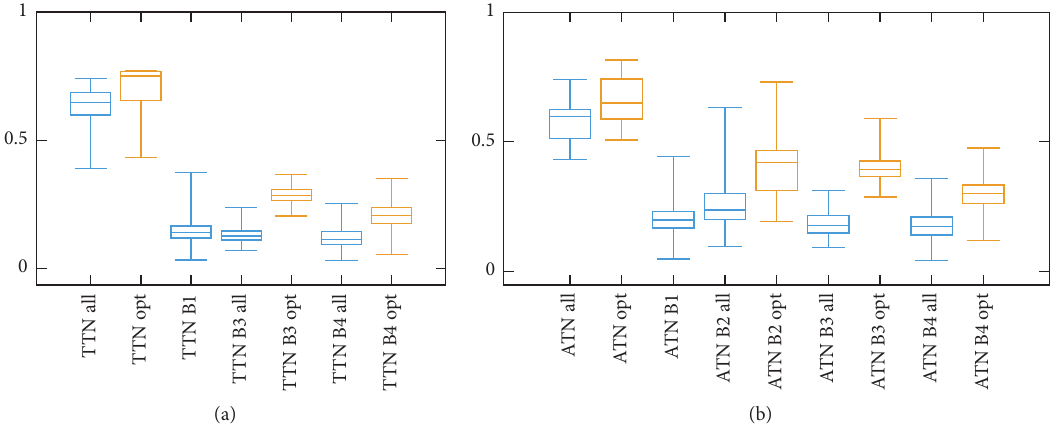
Figure 17: (a) Boxplots of F -scores obtained for classifying TTNs contrasted by the baselines B1, B3, and B4. (b) Boxplots of F -scores obtained for classifying ATNs contrasted by the baselines B1, B2, B3, and B4.